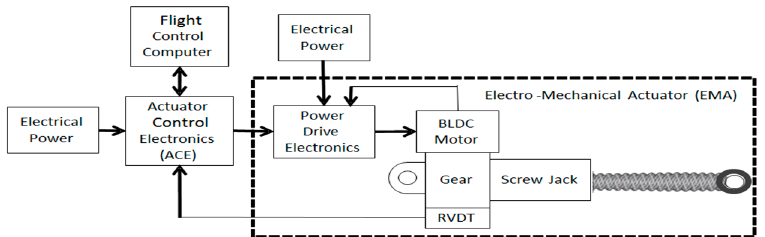
Figure 1. Block diagram of a typical Electro-Mechanical Actuator (EMA) architecture.